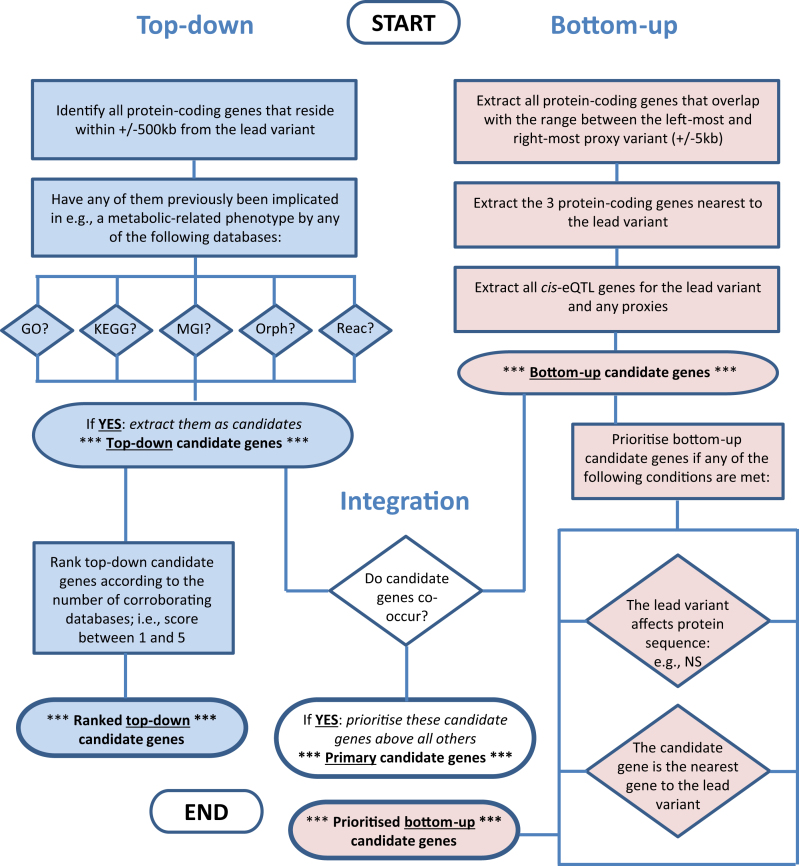
ProGeM: a framework for identifying and prioritizing candidate causal genes at molecular QTLs. A proxy is defined as those variants with r2 ≥ 0.8 with the sentinel variant (1000 Genomes Project, EUR Super Population). GTEx v7 data were used as a source for identifying cis-eQTLs. GO; Gene Ontology, KEGG, MGI; Mouse Genome Informatics, Orph; Orphanet, Reac; Reactome, NS; non-synonymous.